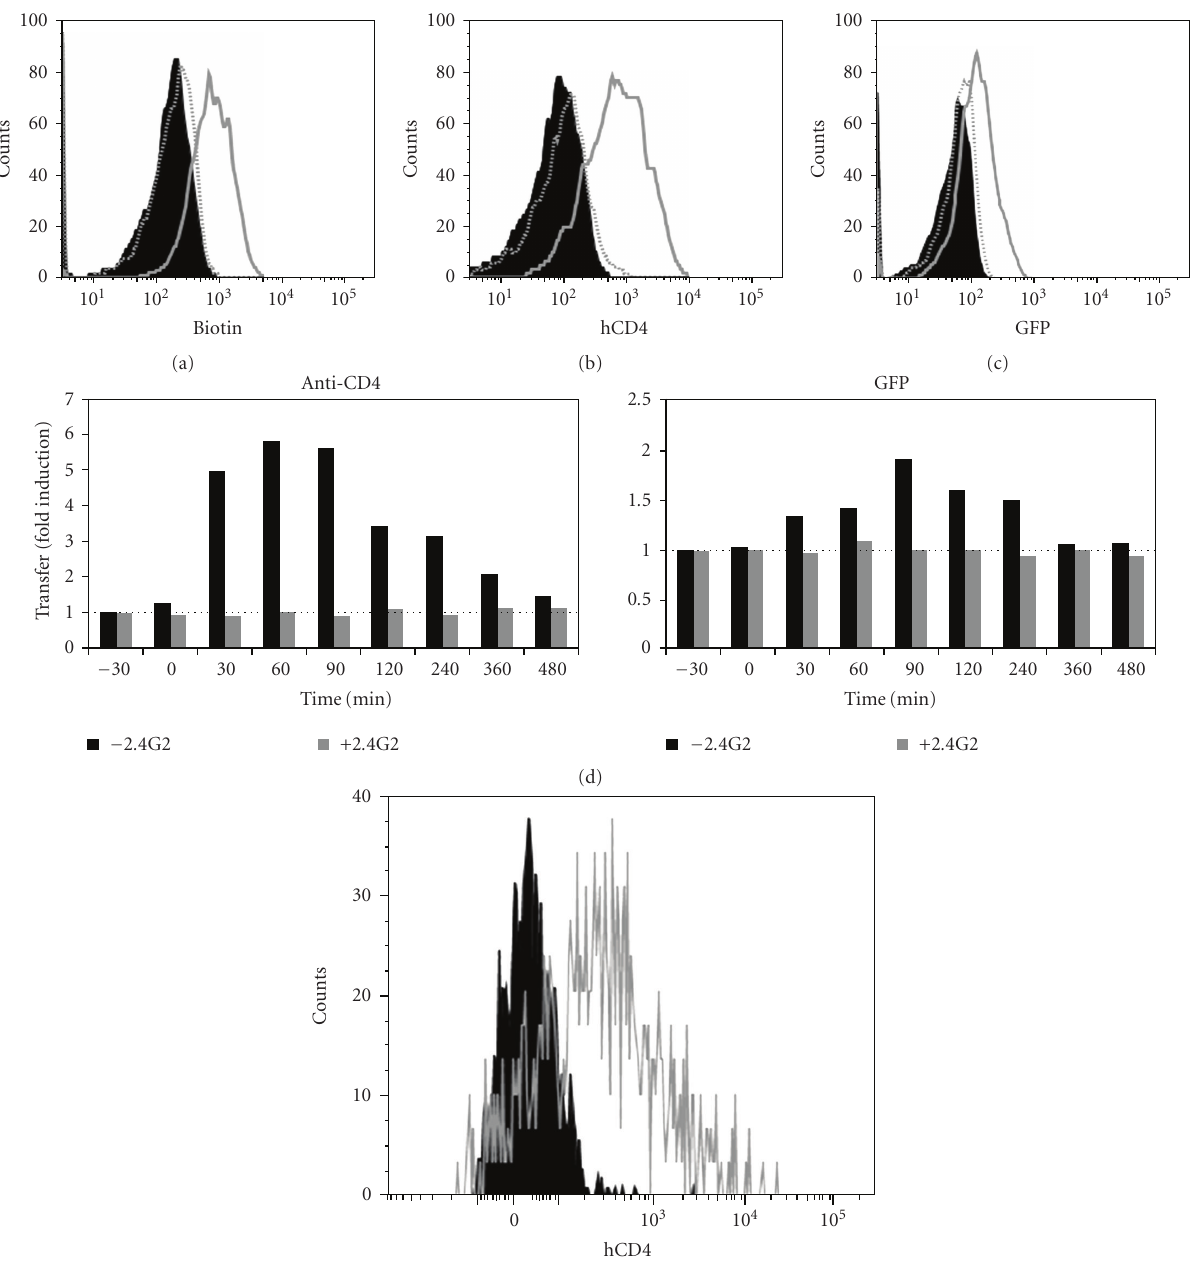
Figure 2: CD8 + T cells from healthy donors and HIV + patients capture CD4 and membrane fragments from P815-CD4-GFP cells during redirected trogocytosis. CD8 + T cells, immunomagnetically purified from human PBMC, were coated (grey open histogram) or not (black close histogram) with anti-CD3 + anti-CD28 mAb, then incubated with P815 cells expressing human CD4 fused to GFP, which had been previously cell surface biotinylated. (a) Cells were analyzed by flow cytometry for biotin capture using fluorescent streptavidin and CD8 expression. Shown are overlapping histograms of biotin detection on gated CD8 + T cells from healthy donor. Grey dotted open histogram shows biotin capture by anti-CD3 + anti-CD28-coated CD8 + T cells exposed to Fc γ RII/III-coated P815 cells previously coated by 2.4G2 mAb. (b) As in (a) except that CD4 rather than biotin capture was determined and is shown on gated CD8 + T cells from healthy donor. (c) As in (b) except that GFP rather than CD4 capture was determined and is shown on gated CD8 + T cells from healthy donor. (d) Kinetics of the transfer e ffi ciency of CD4-GFP on CD8 + T cells co-incubated with P815-CD4-GFP. Transfer of CD4-GFP on CD8 + T cells was detected using anti-CD4 mAb (left panel) and GFP fluorescence (right panel). Results show the fold-induction, that is, the CD4 or GFP fluorescence on CD8 + T cells obtained from cocultures in the presence of stimulatory anti-CD3 + CD28 mAb divided by those obtained in the absence of stimulatory mAb. The experiments were performed in the presence (grey histograms) or absence (black histograms) of the blocking 2.4G2 mAb. (e) As in (b) except that CD8 + T cells were purified from PBMC of a-HIV-infected patient. Since we had only a few cells, we could not perform the control experiment with the blocking 2.4G2 mAb. Note that, in each case, similar results were obtained in at least three independent